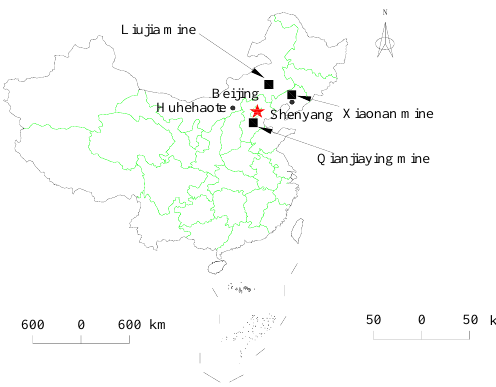
Figure 5. Locations of coal specimens.